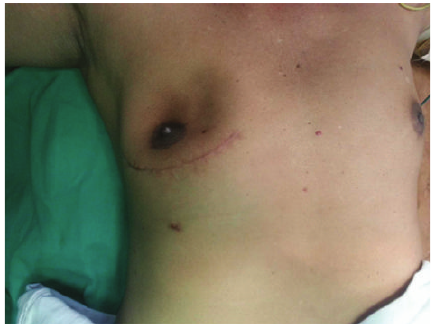
Figure 2: Excision biopsy of the lump done through an elliptical inframammary incision.